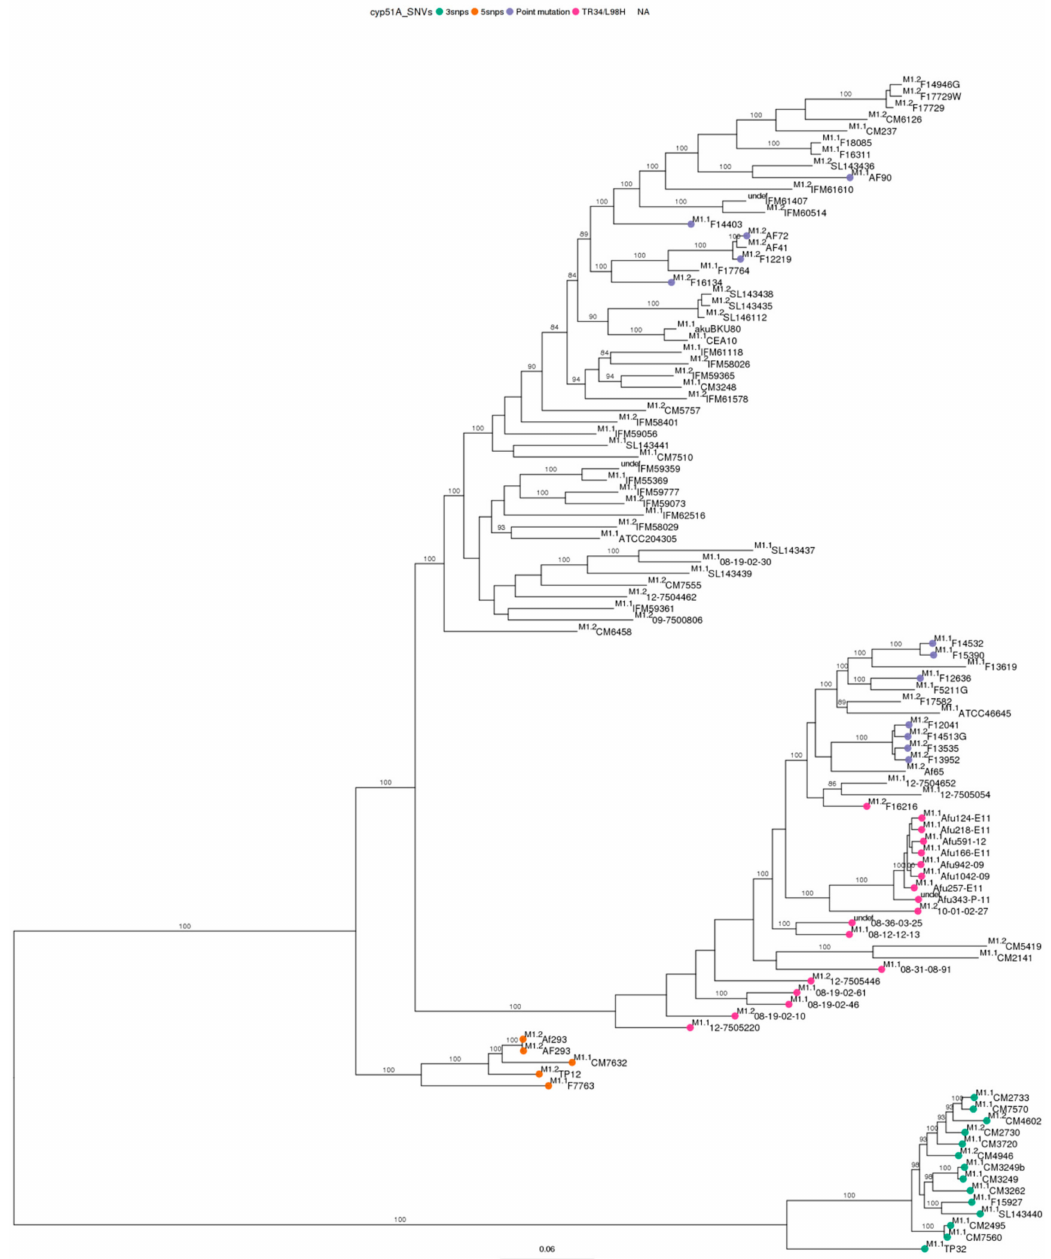
Figure 1. Whole genome phylogenetic analysis of 101 Aspergillus fumigatus genomes included in the study. Dendrogram was performed using Af293 as reference